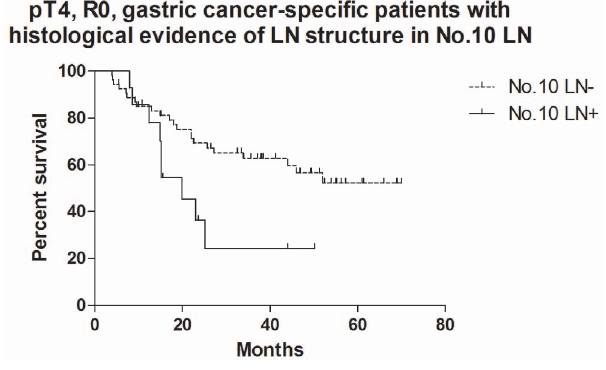
Figure 11. Kaplan-Meier survival analysis of pT4 stage gastric cancer specific + R0 resection group in patients with histolog- ical evidence of LNs structure in No.10 LNs.